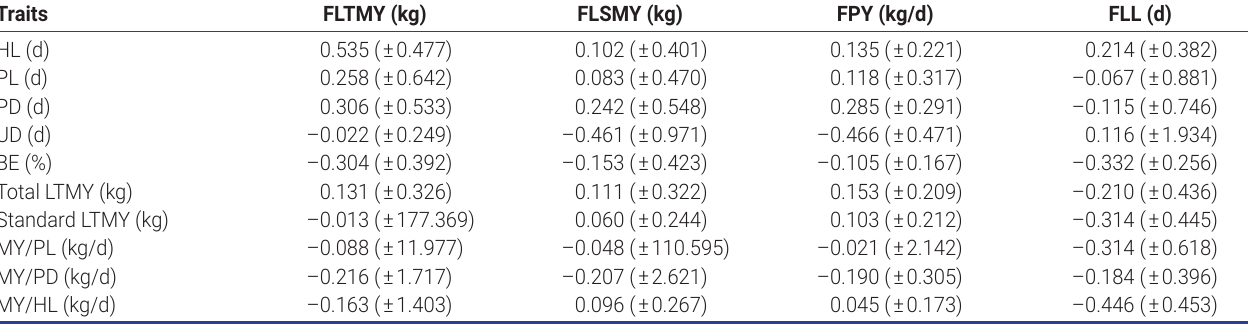
Table 5. Genetic correlation between first lactation production and lifetime traits in Murrah buffaloes Traits